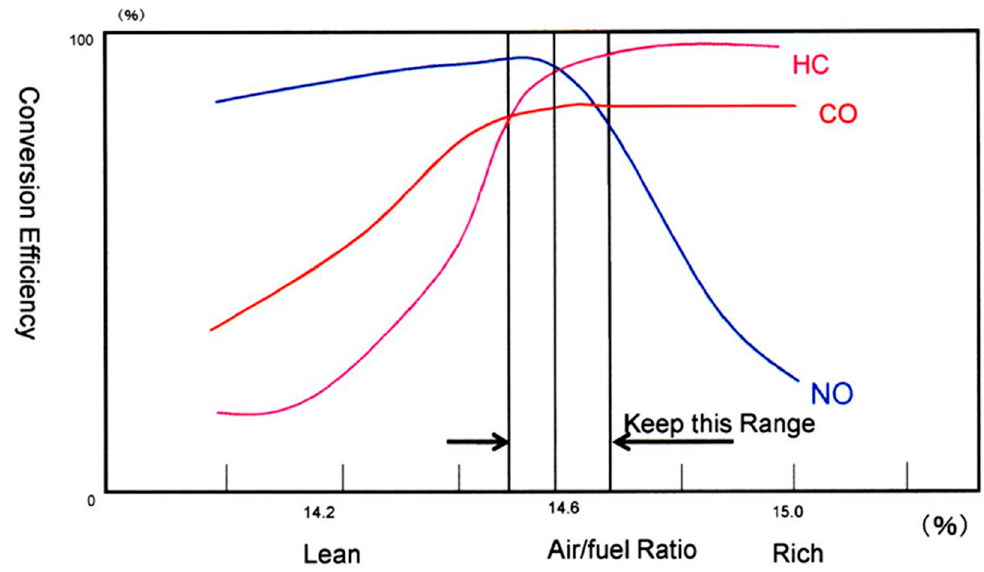
Figure 2. Changes of conversion efficiency of three pollutants along the air/fuel ratio.